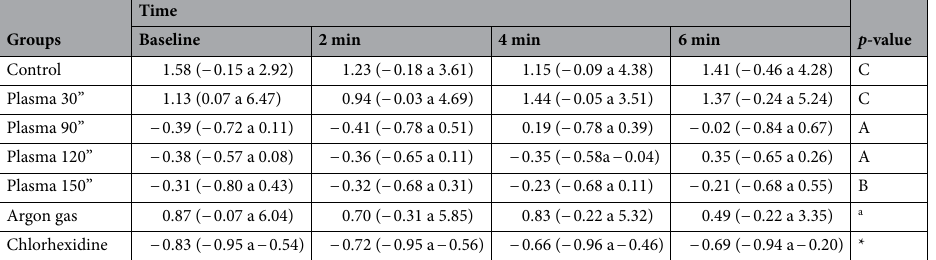
Table 3. Median (minimum and maximum) values of antibacterial efficacy of plasma treatment on S. mutans biofilm in terms of metabolic activity. Groups having similar letters are not significantly differences ( p > 0.05), *Indicates significantly differences with all the groups, a Indicates differences with P90, P120 and P150 groups.